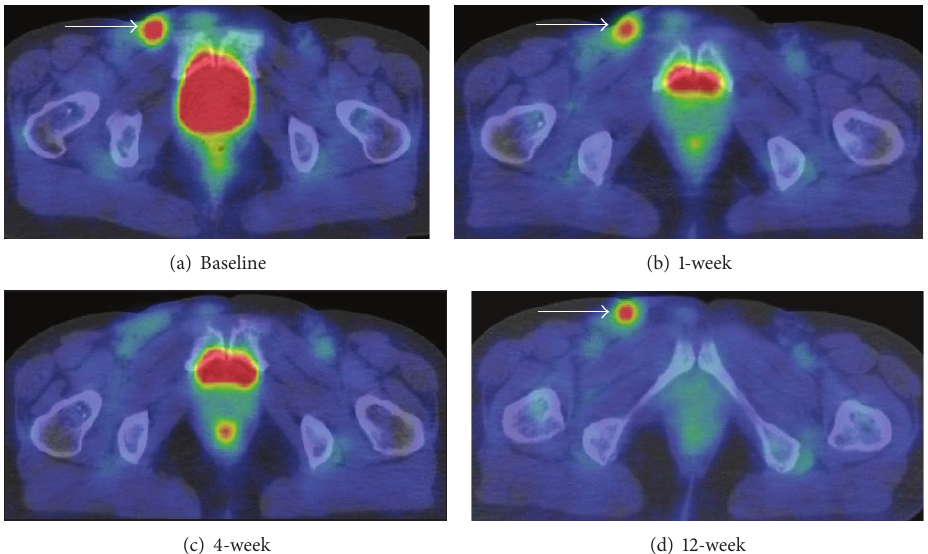
Figure 5: Axial images at level of inguinal region of patient 7. (a) Baseline, (b) 1-week scan, (c) 4-week scan, and (d) 12-week scan. FDG-avid lesion is seen in the right inguinal lesion (arrow). FDG uptake decrease for up to 4 weeks and the degree of the uptake is not remarkable at 4 weeks, but the declining metabolism turns to increase from 4 weeks to 12 weeks. Physiological activities are seen in the bladder and the